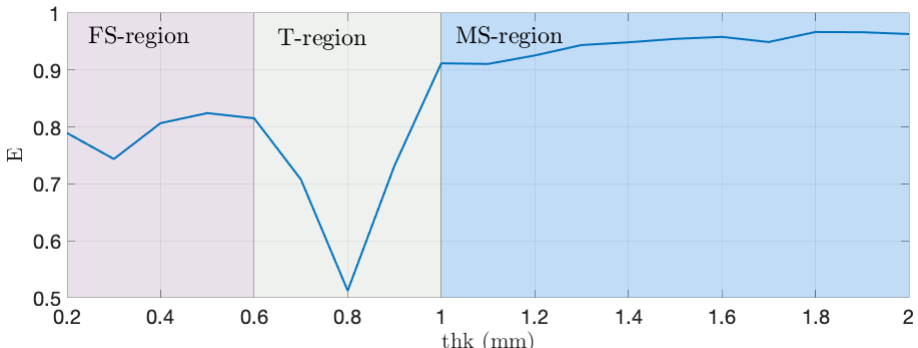
Figure 5. Eccentricity ( E ) resulting from simulation set S 2 as a function of specimen thickness. The three main zones are depicted: Fraunhofer region (FS-region), Transient region (T-region) and Multiple Scattering region (MS-region).